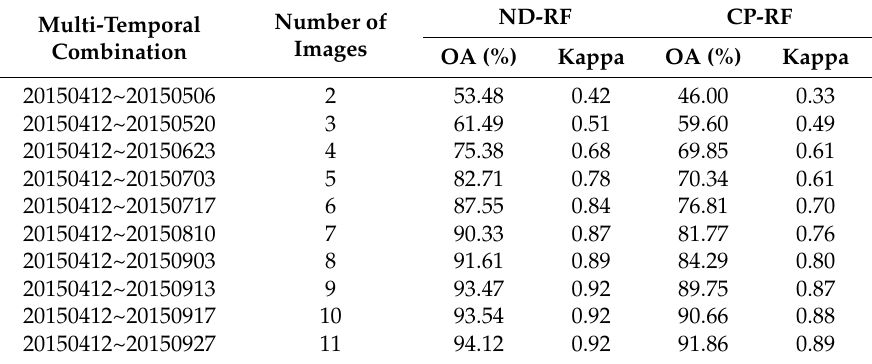
Table 4. The overall accuracy and Kappa coefficient of ND-RF and CP-RF classification methods with different combinations of multi-temporal RADARSAT-2